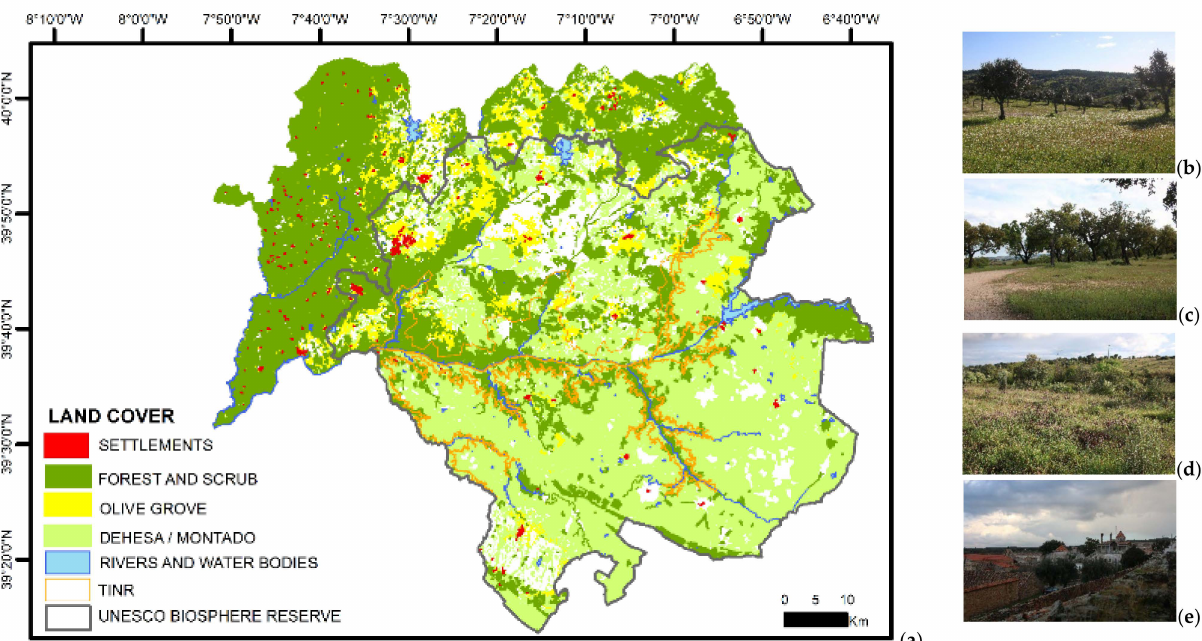
Figure 2. ( a ) Main land uses. ( b ) Olive grove. ( c ) Agro-silvo-pastoral system. ( d ) Mediterranean forest. ( e ) Rural